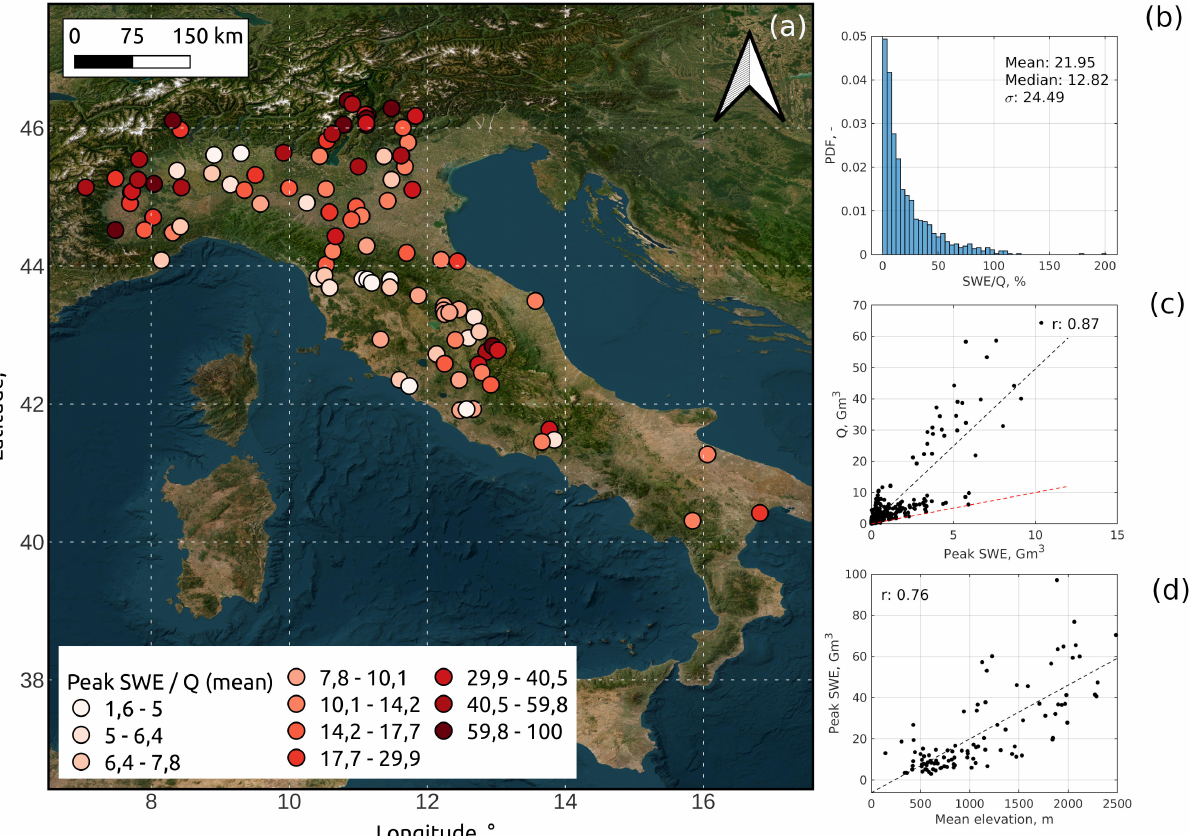
Figure 9. Indirect validation of IT-SNOW with streamflow data. (a) Mean annual ratios (in %) between peak SWE and annual cumulative streamflow for a selection of 102 water basins with long-term, serially complete, and quality-checked time series of streamflow. (b) Frequency distribution of these annual ratios across all sections and years. (c) Correlation between annual streamflow and annual peak SWE across all sections and years (red line is the 1 : 1 reference line; the black dashed line is a linear regression between peak SWE and annual streamflow). (d) Correlation between mean peak SWE and river basin mean elevation (the black dashed line is a linear regression between these two data). Q is annual streamflow. Note that considered water sections of the central Po river valley do not account for snow accumulated in the Swiss canton Ticino, which is not included in IT-SNOW (Ticino represents about 5% of the Po river basin at its most downstream closure section). The background map is from the Esri satellite theme. SWE is expressed here in the form of total volume of water stored in snow (Gm 3 ; see Sect.